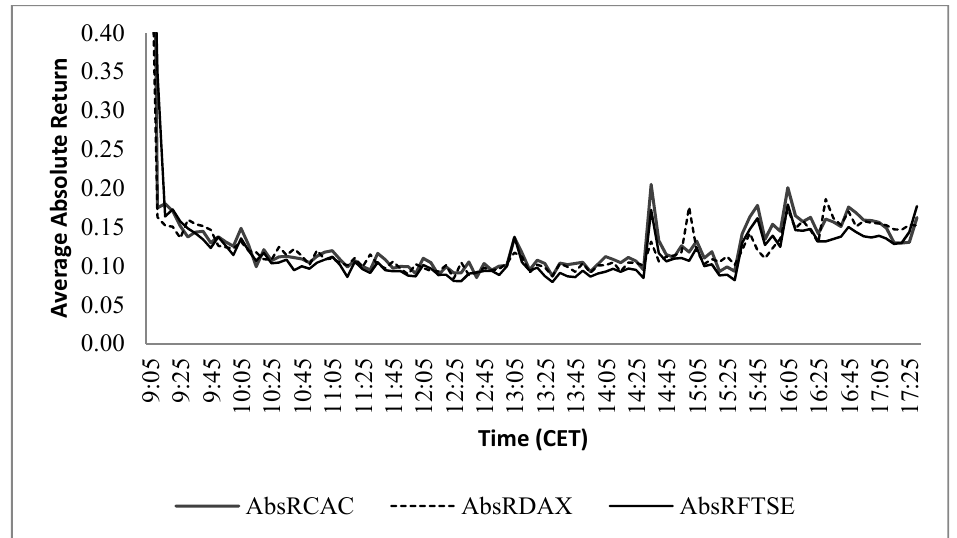
Figure 2. Average intraday volatility evolution in stock markets indices (1 July 2008 to 28 November 2008).